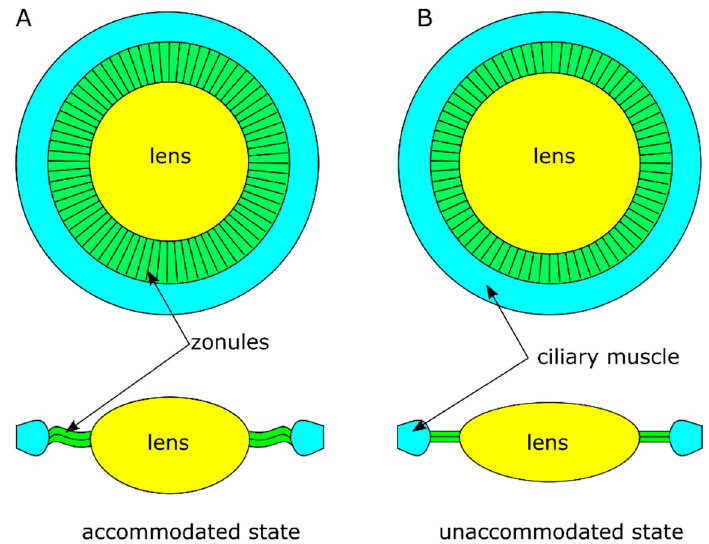
Figure 1. Natural accommodating process of eyes: ( A ) accommodated state for near vision; ( B ) unaccommodated state for distance vision.